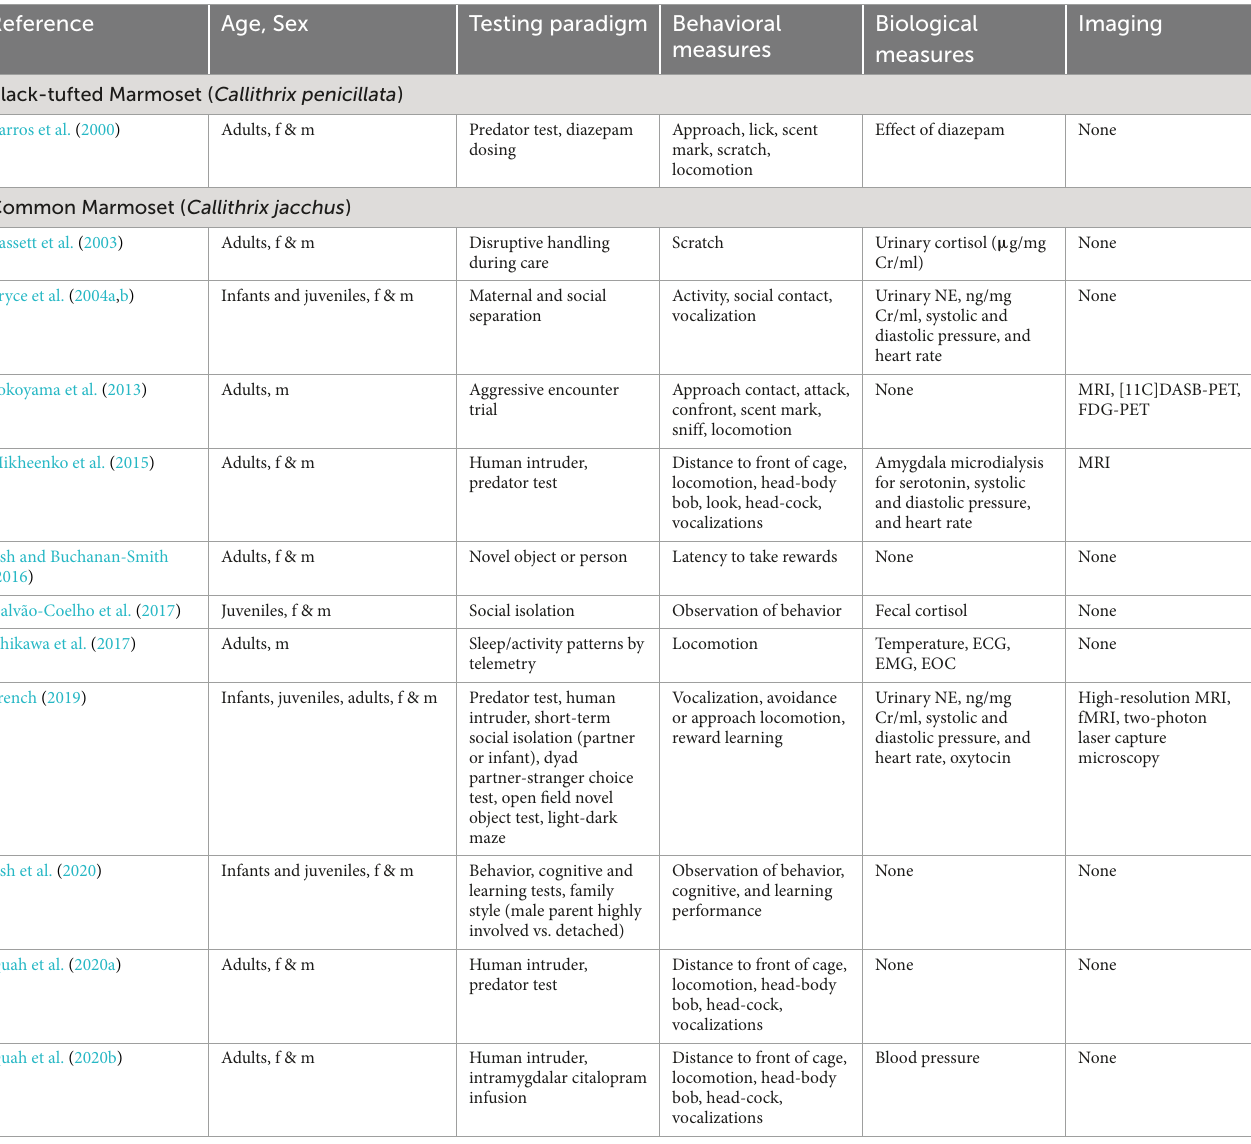
TABLE 2 Selected peer-reviewed publications describing methods of evaluation of depression- and anxiety-like behaviors in species of marmosets (infant = 0–0.5 y; juvenile = 0.5–2 y; adult = 2–8 y).